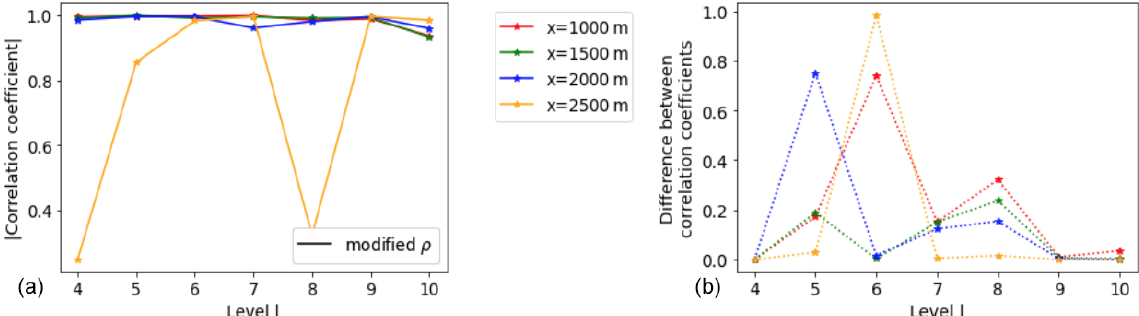
Figure 5. Comparing the real and modified correlation values between SFINCS and XBeach to find water elevation at specific locations in the non-breaking wave test case. Note that each colour represents a specific output location. (a) Absolute value of modified correlation (Eq. 9). (b) Difference between absolute value of modified and real correlation.